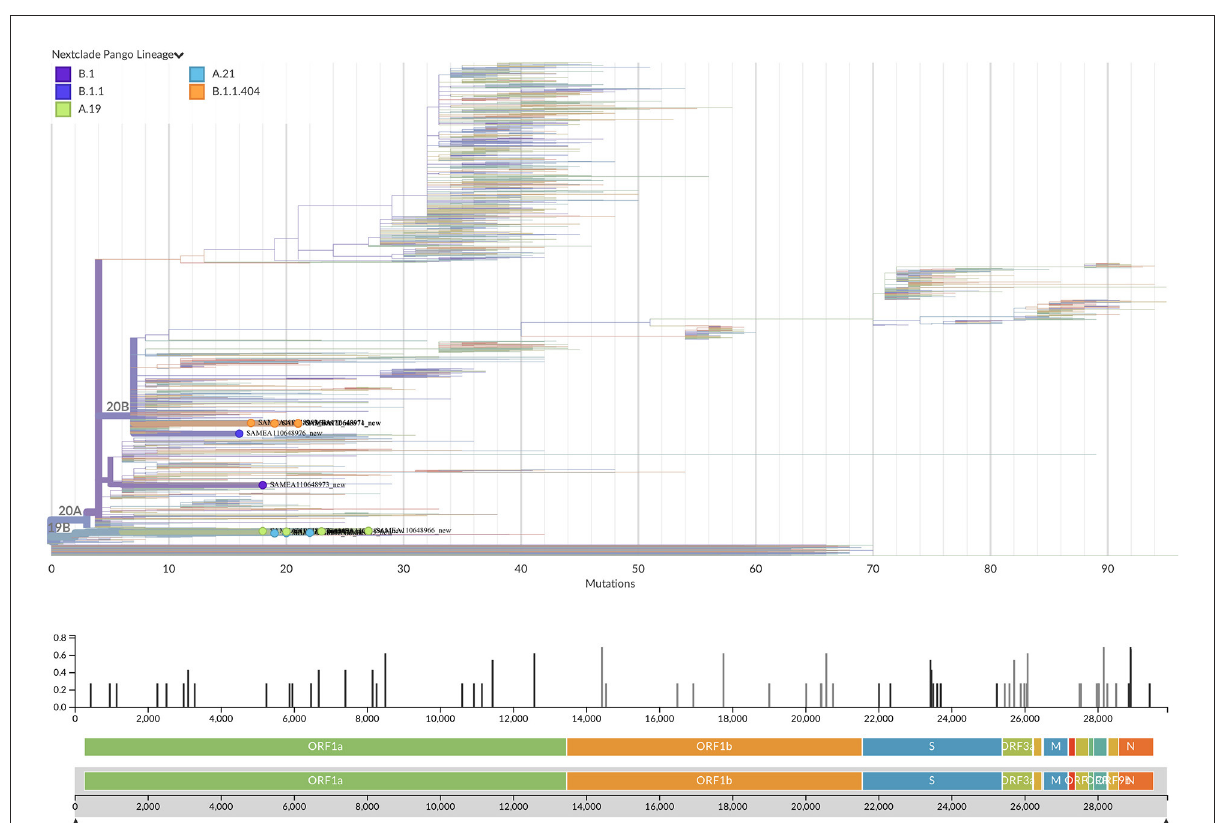
FIGURE2 Phylogenetic tree with the 13 new SARS-CoV-2 Burkina Faso genomes placed on a reference tree of 2022 published sequences from all over the world along with the diversity panel below, a bar-chart showing the variation (i.e., mutations) of the 13 sequences in the genome relative to the reference sequence Wuhan-Hu-1/2019 (MN908947). Phylogenetic tree generated with Nextclade online software v2.5.0 (https://clades. nextstrain.org) (accessed on 13 September 2022) and visualized using Auspice v2.37.3 (https://auspice.us/) (accessed on 13 September